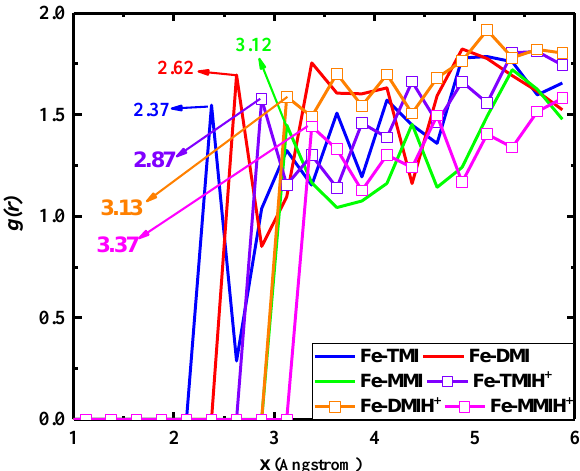
Figure 8. Radial Distribution Functions (RDFs) of neutral and protonated forms of the tested corrosion inhibitors adsorbed on the Fe (110) surface in solution.